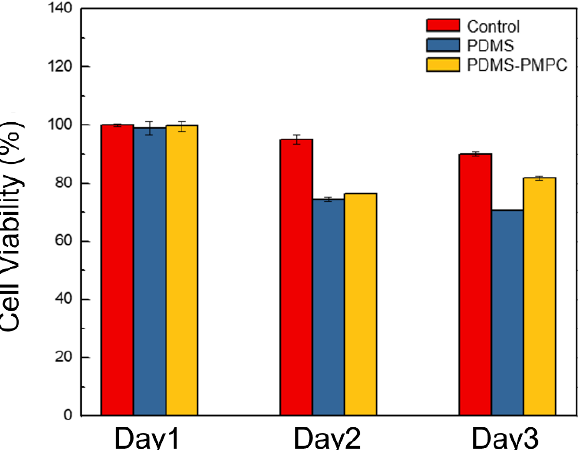
Figure 13. Biocompatibility tests of control, pristine PDMS, and PDMS-PMPC substrates ( n = 3).